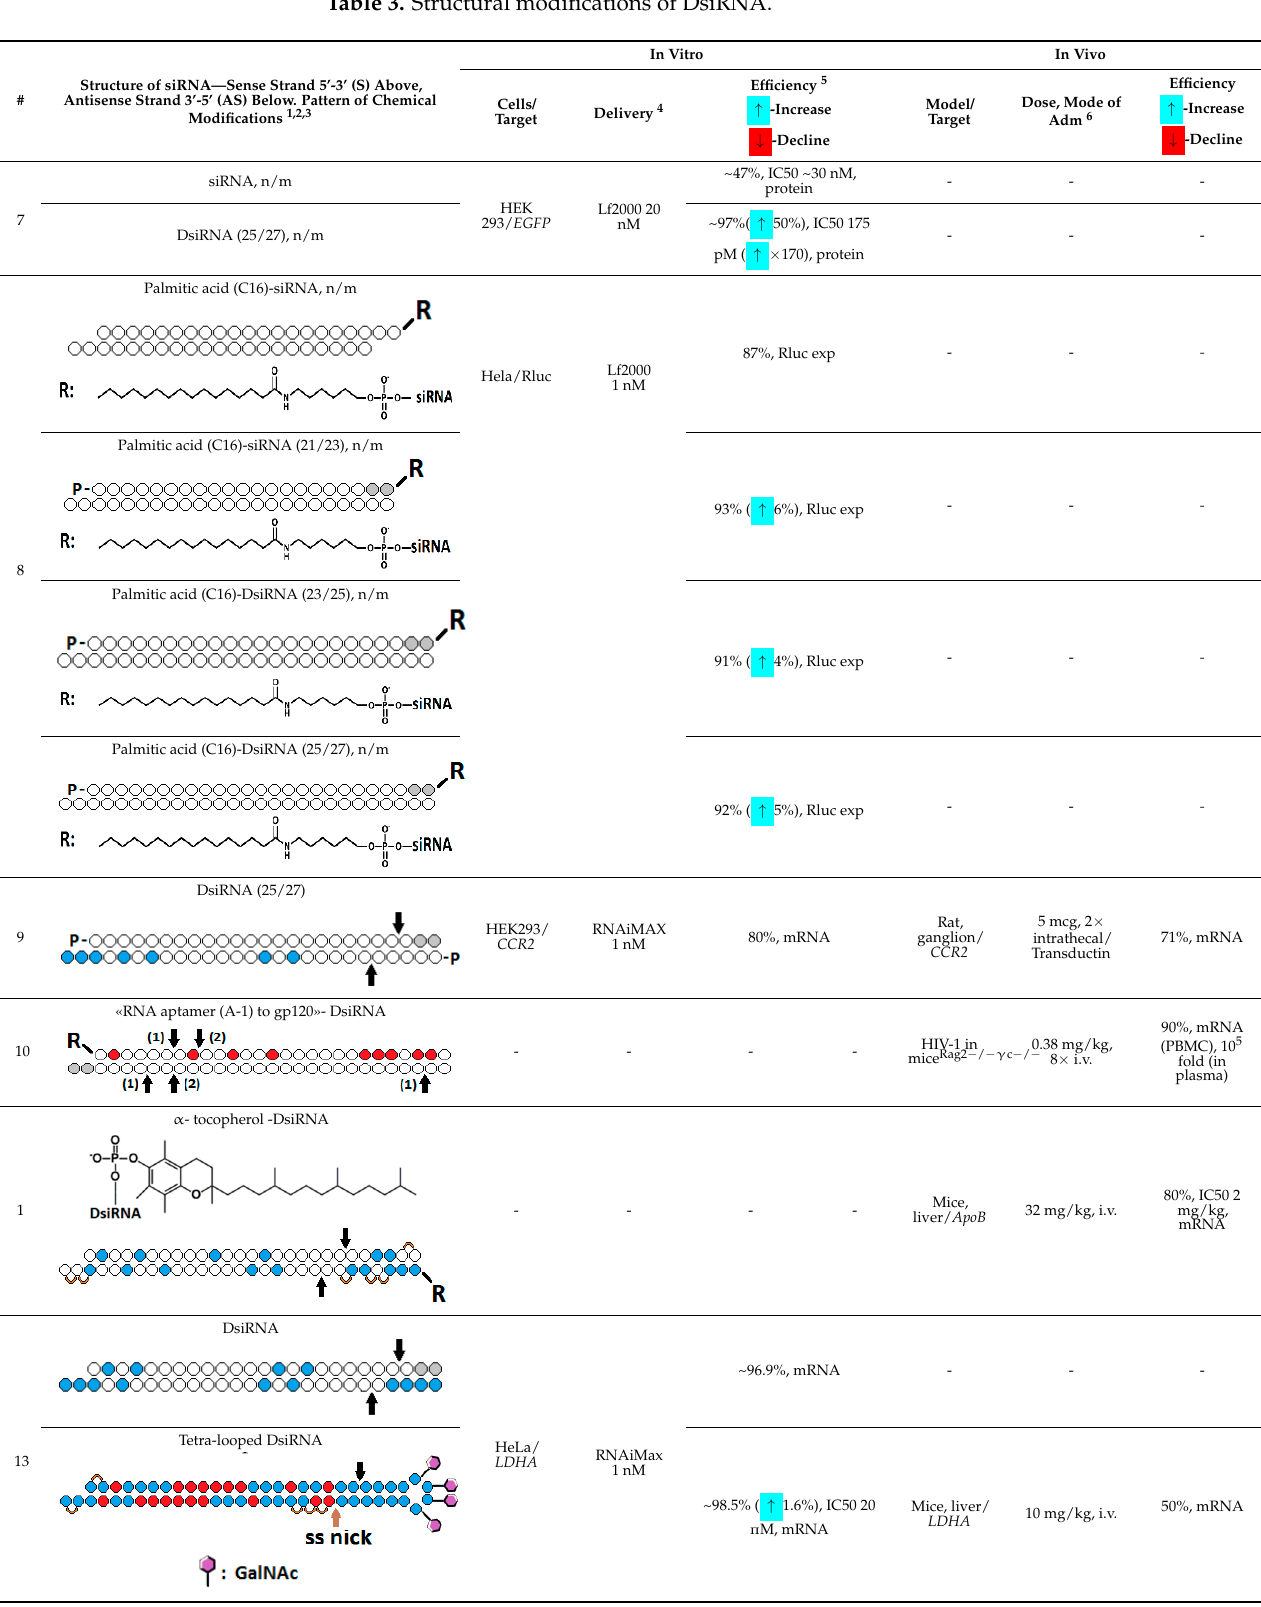
Table 3. Structural modifications of Table 3. Structural modifications of DsiRNA. Table 3. Structural modifications of DsiRNA. Table 3. Structural modifications of DsiRNA. Table 3. Structural modifications of DsiRNA. Table 3. Structural modifications of DsiRNA. Table 3. Structural modifications of DsiRNA. Table 3. Structural modifications of DsiRNA. Table 3. Structural modifications of DsiRNA. Table 3. Structural modifications of DsiRNA. Table 3. Structural modifications of DsiRNA. Table 3. Structural modifications of DsiRNA. Table 3. Structural modifications of DsiRNA.